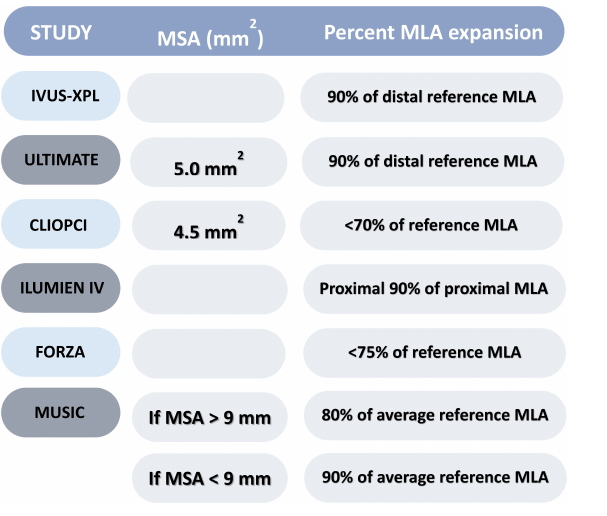
TABLE 3 | Stent expansion criteria of different